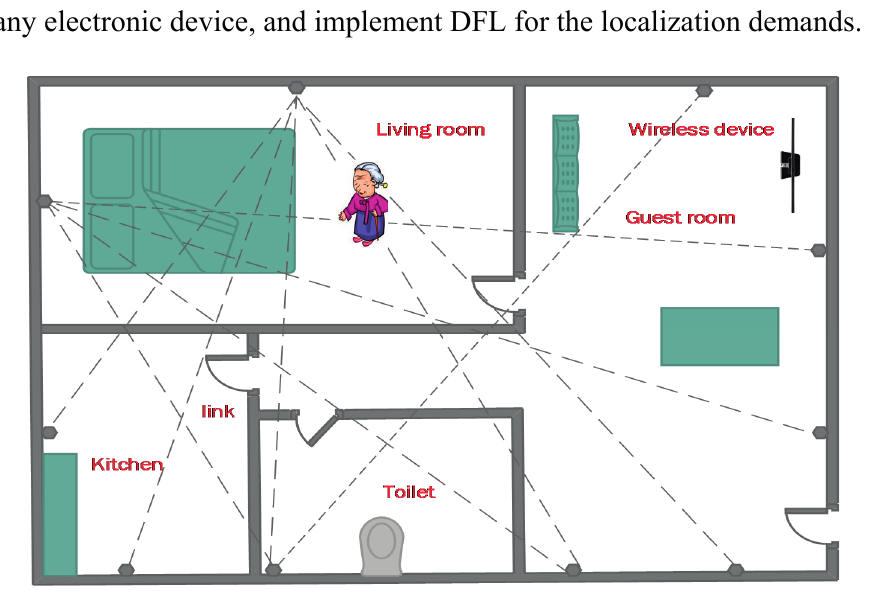
Figure 1. DFL application scenario for aging at